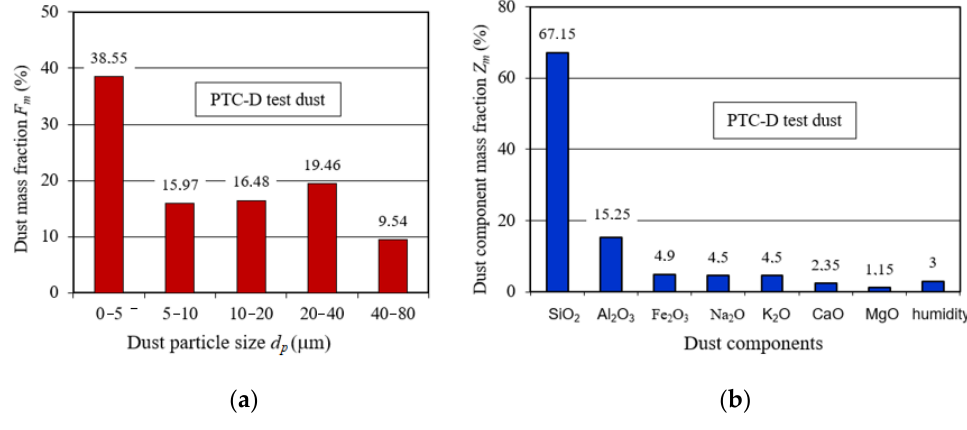
Figure 31. PTC-D test dust: ( a ) size distribution and ( b ) chemical composition [99]. The separation efficiency c of the cyclone was determined by the mass method for successively determined values of the air stream within the range Q G = 6–34 m 3 /h (in equal intervals, every 4 m 3 /h) and for corresponding values of the suction flows Q S for the assumed degree of ejection of dust from the cyclone settling pond m 0 = 8%.